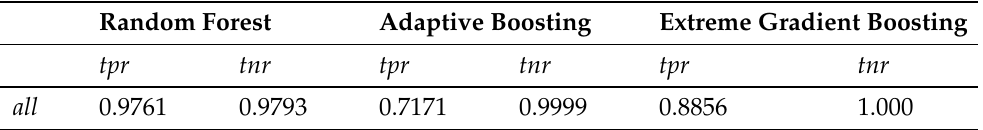
Table 17. Extended PaySim dataset ensemble methods based fraud